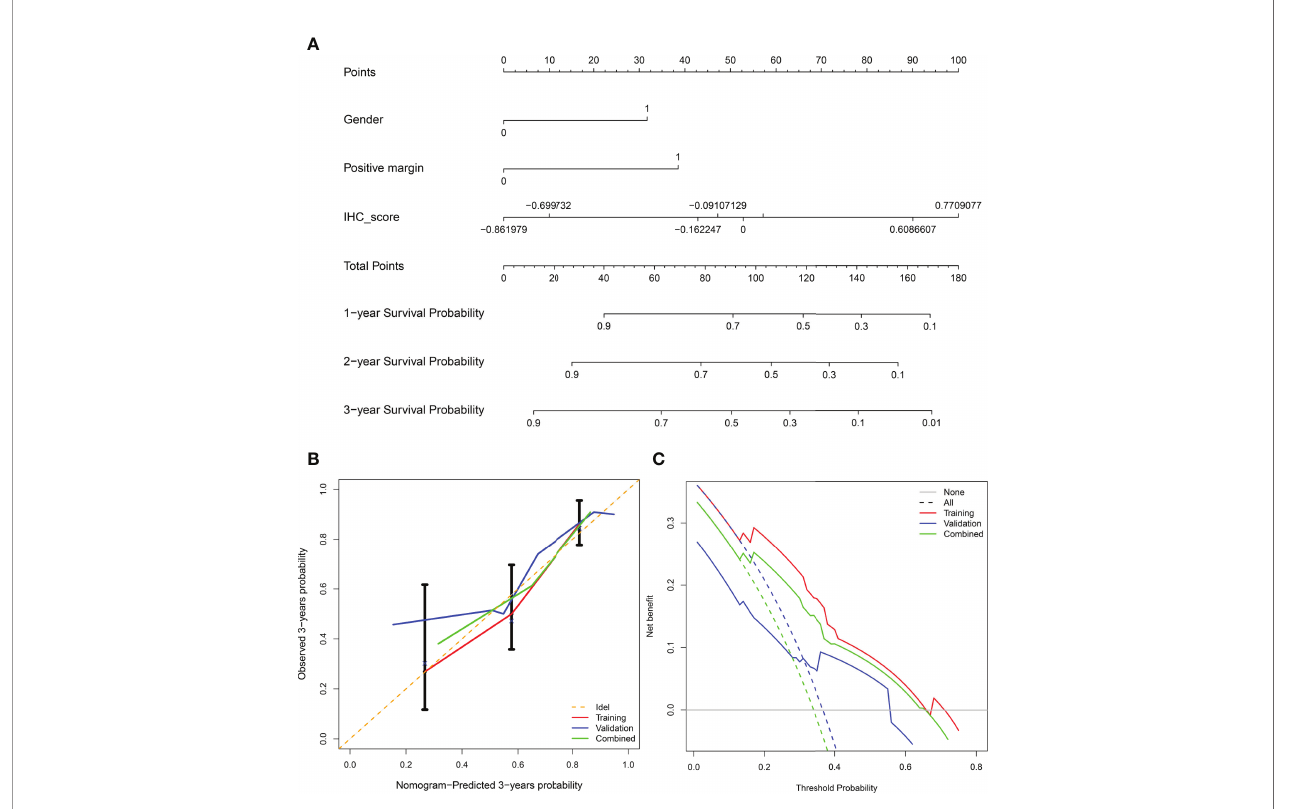
FIGURE 5 | (A) Nomogram for predicting recurrence-free survival of patients at 1,2,3-year. (B) Calibration curve of the nomogram in predicting recurrence-free survival at 3-years in the training cohort, validation cohort, and combined cohort. X-axis: prediction of recurrence in patients. Y-axis: actual diagnosed recurrence. (C) Decision curve of the nomogram for 3-year recurrence-free survival in three